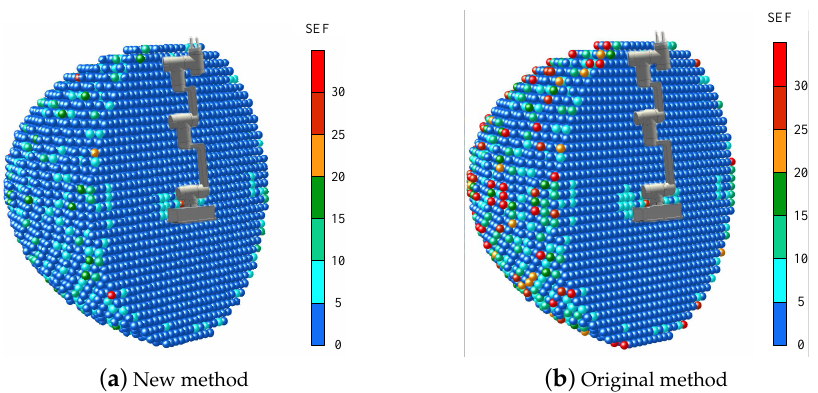
Figure 10. The SEF of the reachability spheres in the workspace by the two